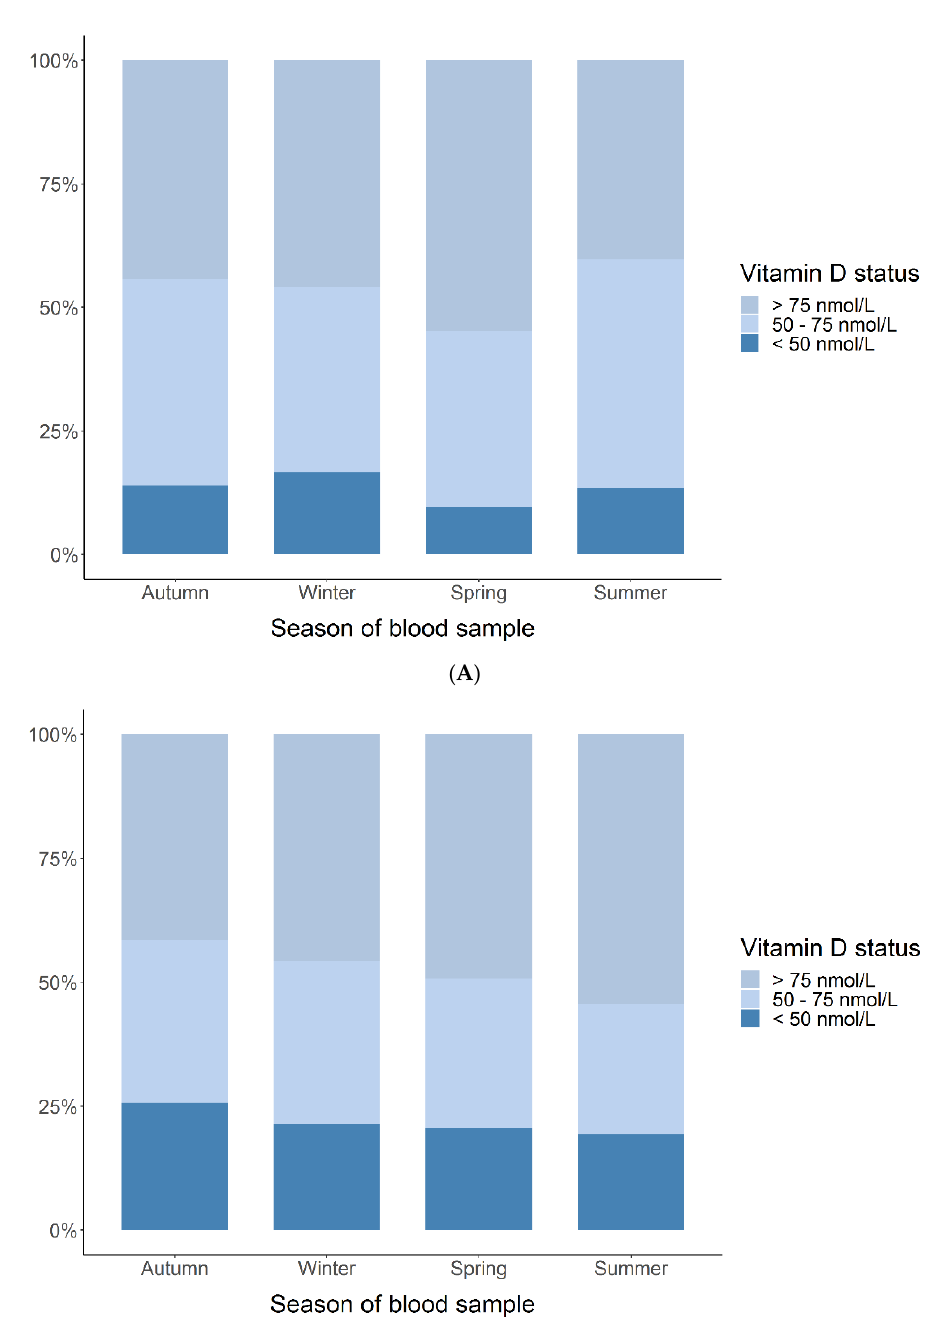
Figure 1. Maternal 25(OH)-vitamin D (25(OH)D) status (deficient (<50 nmol/L), insufficient (50–75 nmol/L), sufficient (>75 nmol/L)) at week 24 ( A ) and one week postpartum ( B ) stratified for season of blood